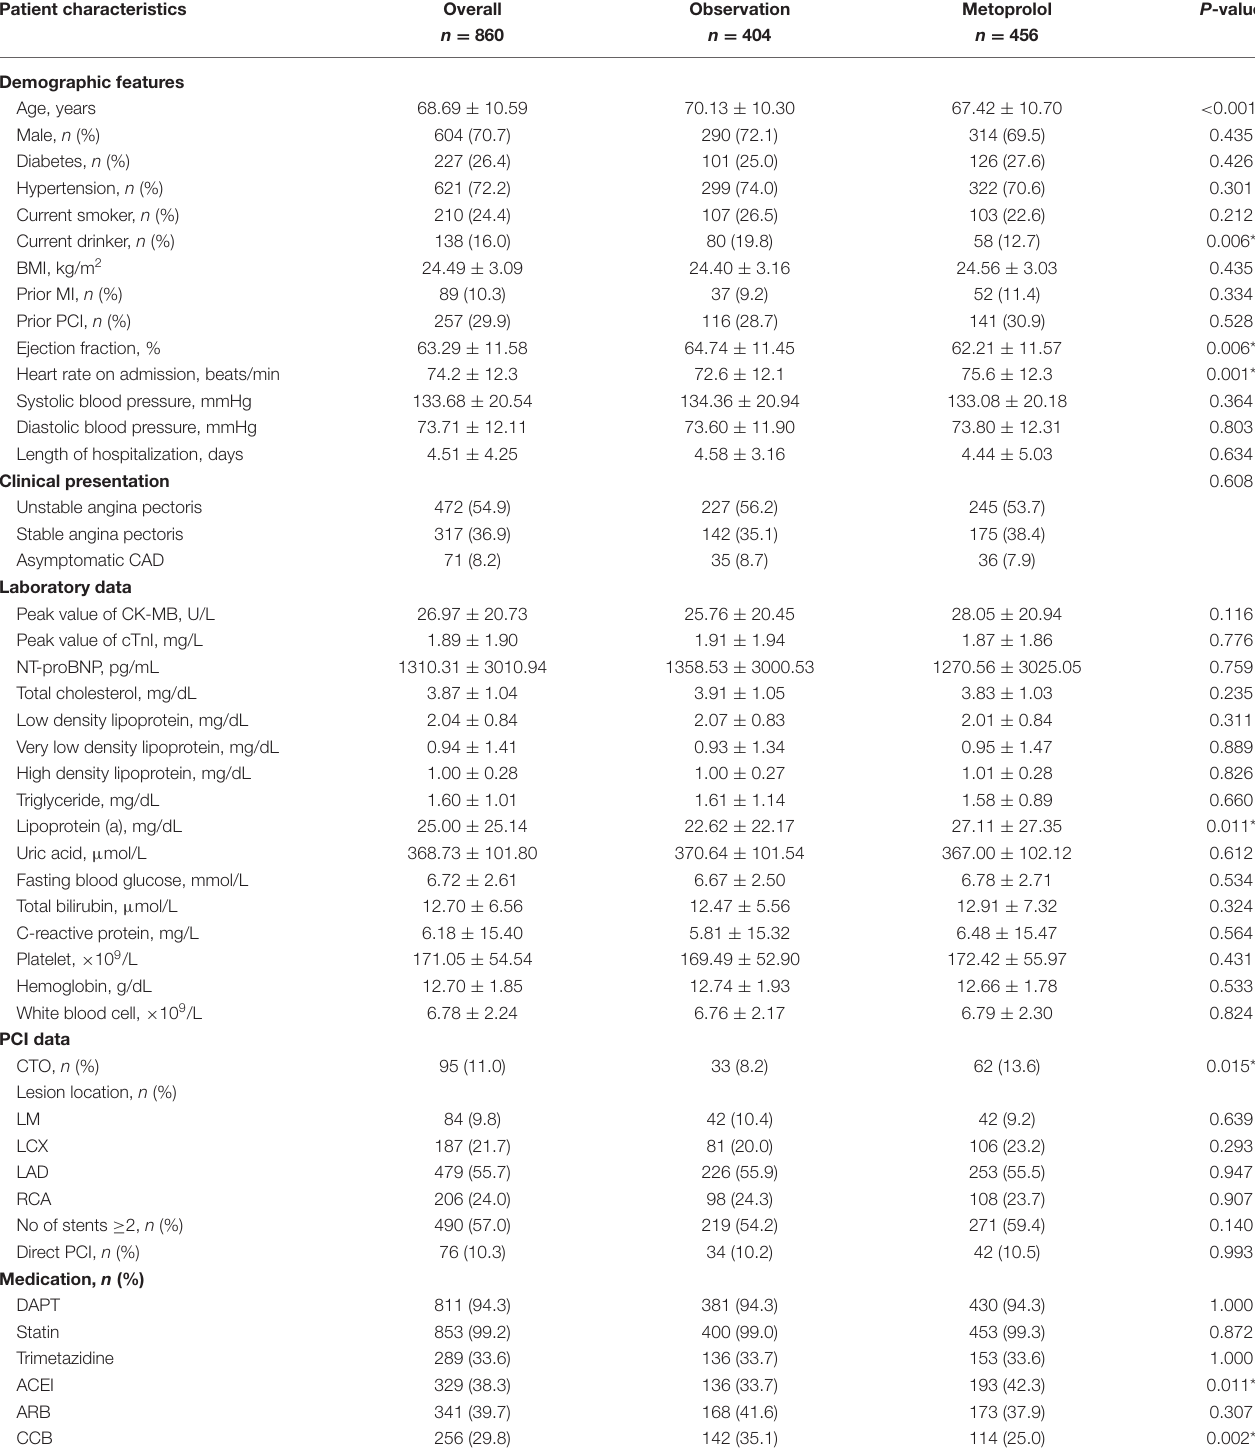
TABLE 1 | Unweighted baseline